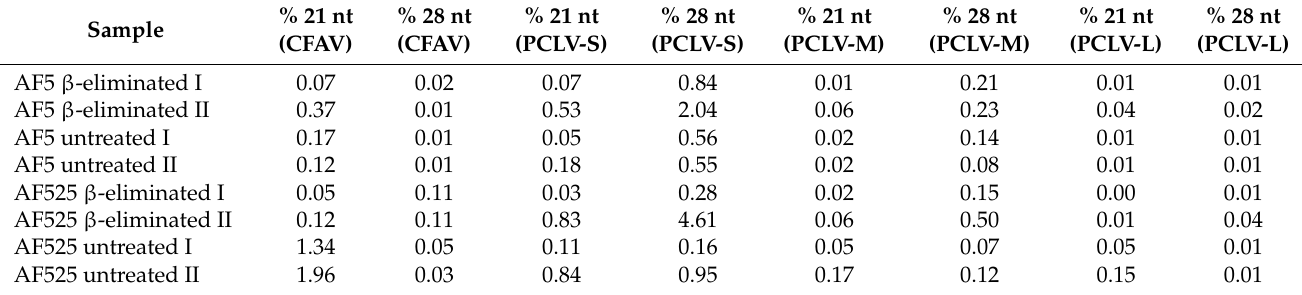
Table 2. Analysis of clean reads in AF5 and AF525 cells persistently infected with CFAV and PCLV and treated with β -elimination reagents. Percentage of total reads of 21 nt (% 21 nt) and 28 nt (% 28nt) long RNAs mapping to CFAV or PCLV S-, M- and L-segment. Small RNAs of 21 nt are used as a representative for siRNAs and 28 nt long reads for piRNAs. Data from two independent sequencing runs are